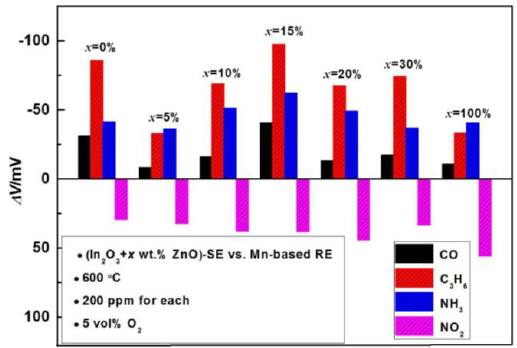
Figure 2. Comparison of the sensing characteristics for the sensors comprised of various composite SEs (calcined at 1000 °C for 2 h) to 200 ppm sample gases, operated at 600 °C.